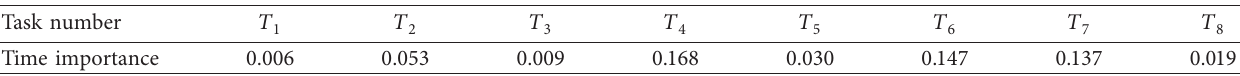
Table 4: Complexity of each task.